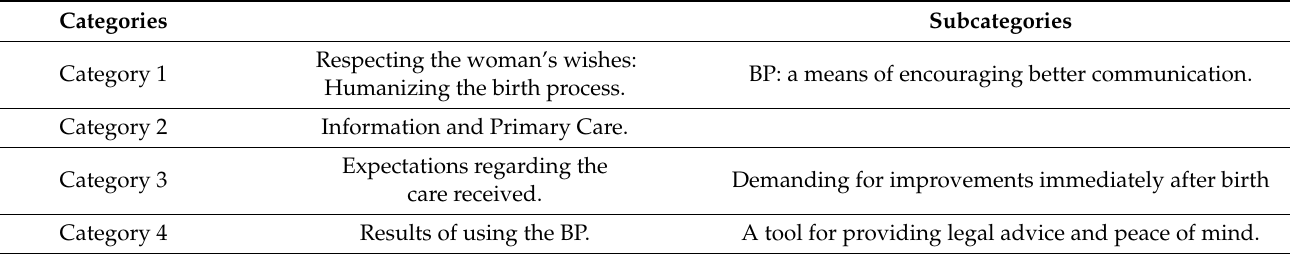
Table 1. Analysis